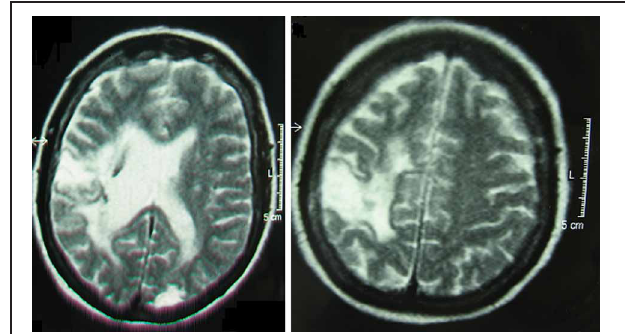
FIGURE 1 | Magnetic Resonance images of EB’s brain lesion. Following the radiological convention, the right hemisphere is on the left side of the